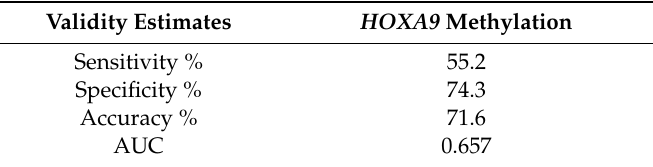
Table 5. Biomarker performance of HOXA9 promoter gene methylation for SCC detection in study group #1 (tissue